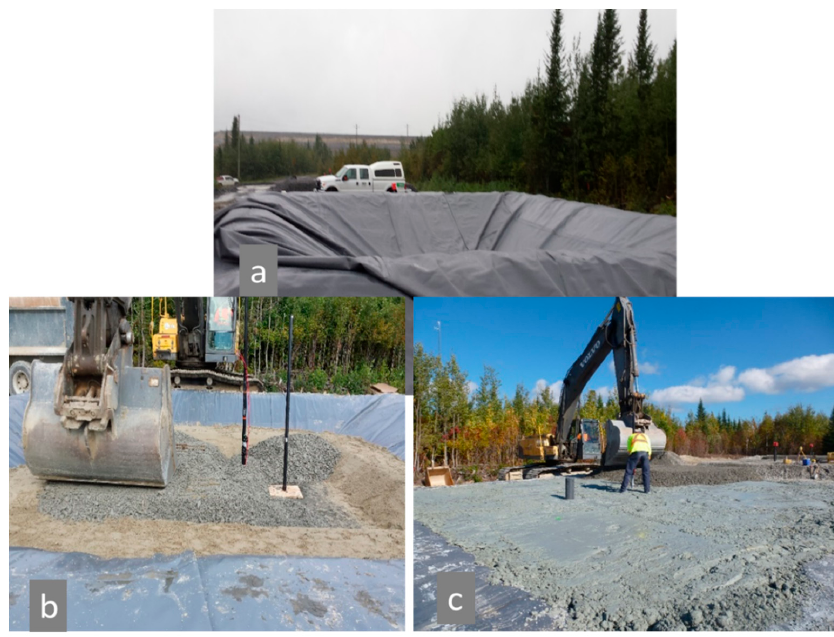
Figure 3. Geomembrane installation ( a ) and sensor placement and installation of the different layers of the field experimental cell ( b ) and ( c ).